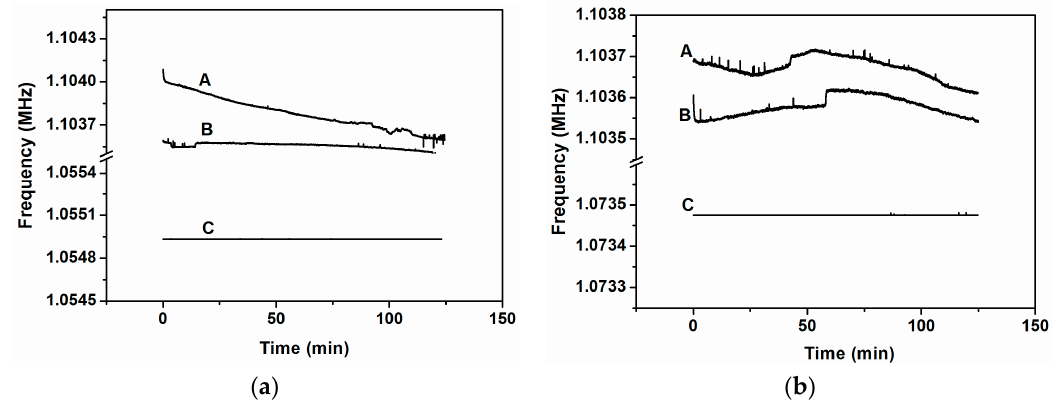
Figure 6. ( a ) Closed-loop frequencies for stimulus at cantilever number 2 (modal frequency, f 02 = 1.0549 MHz) with different frequencies: A , at 1.06 MHz (above f 02 ); B , at 1.04 MHz (below f 02 ); C , at 1.0549 MHz (exactly at f 02 ); ( b ) Closed-loop frequencies for stimulus at cantilever number 4 (modal frequency, f 04 = 1.07348 MHz) with different frequencies: A , at 1.08 MHz (above f 04 ); B , at 1.06 MHz (below f 04 ); C , at 1.07348 MHz (exactly at f 04 ).